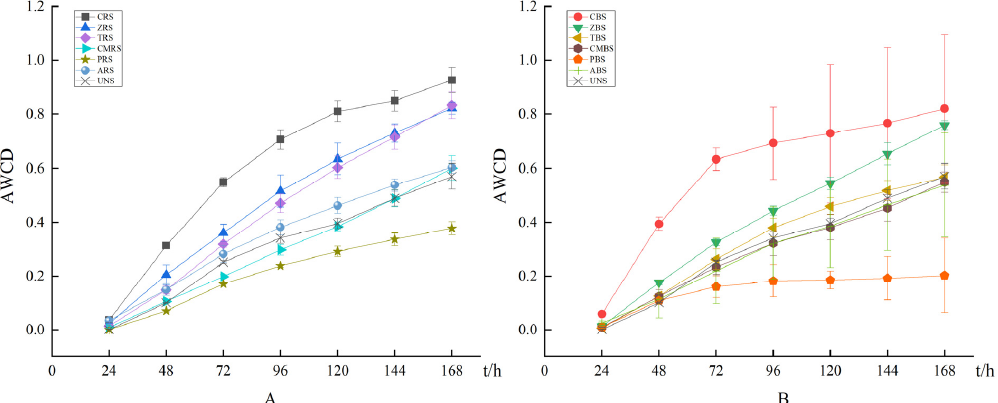
Figure 1. The AWCD values in the microbial community of soil samples increased quickly and then slowly during the cultivation in both rhizosphere soil ( A ); and bulk soil ( B ). The bars represent the means and SD of 3 replicates. CRS/CBS = rhizosphere soil/bulk soil of C. lanceolata , ZRS/ZBS = rhizosphere soil/bulk soil of Z. schneideriana , TRS/TBS = rhizosphere soil/bulk soil of T. ciliate , CMRS/CMBS = rhizosphere soil/bulk soil of C. myrsinifolia , PRS/PBS = rhizosphere soil/bulk soil of P. elliottii , ARS/ABS = rhizosphere soil/bulk soil of A. cremastogyne , UNS = uncontaminated soil.